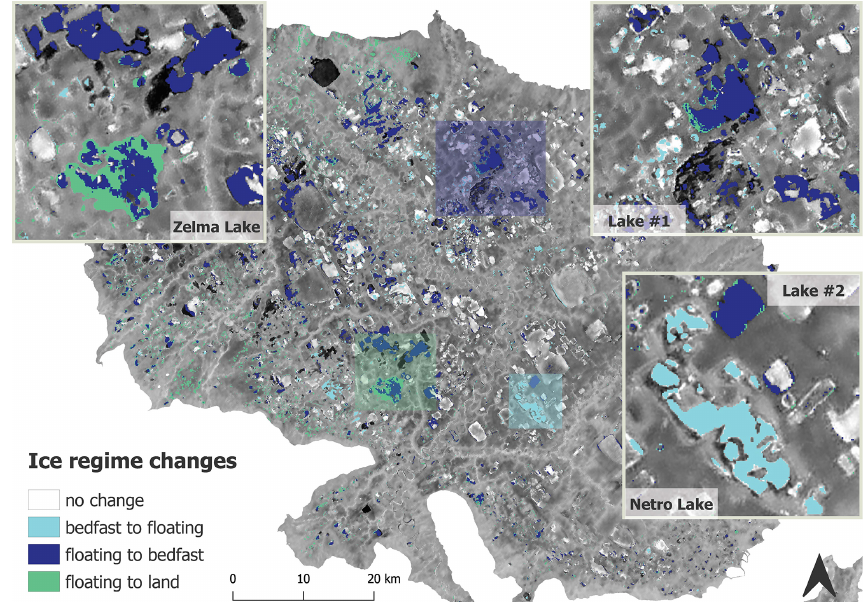
Figure 12. Change detection between 1992/1993 (ERS) and 2020/2021 (Sentinel-1) ice regime maps. Dark blue represents transition from floating to bedfast-ice regime; light blue shows transition from bedfast to floating-ice regime; green stands for transition from floating-ice regime to land. The inset map in the top left corner is a zoomed-in view of the area highlighted as a green rectangle on the main map; top right corner – dark blue rectangle; bottom right corner – light blue rectangle.